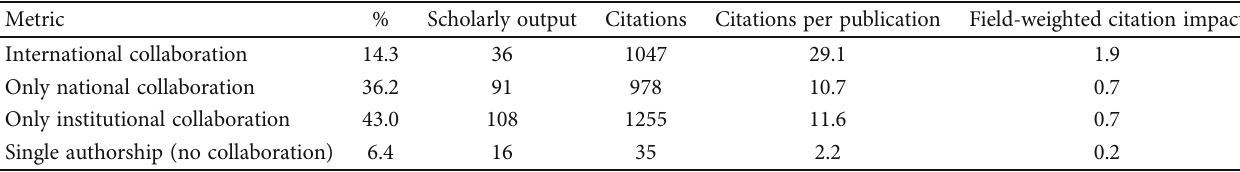
Table 3: All publication types in knife surgery by the amount of international, national, and institutional collaboration. Metric %